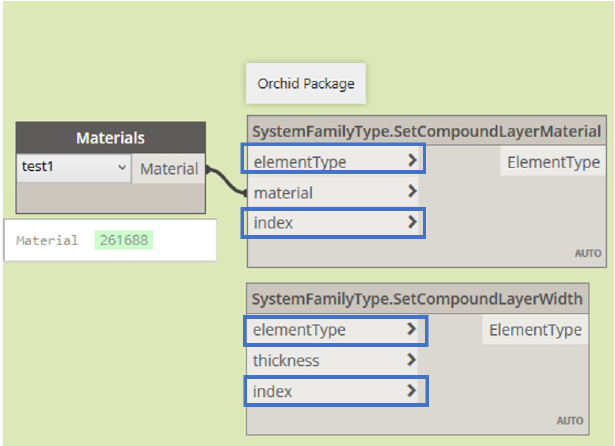
Figure 8. Dynamo Nodes for Instantiating the Insulation Design.